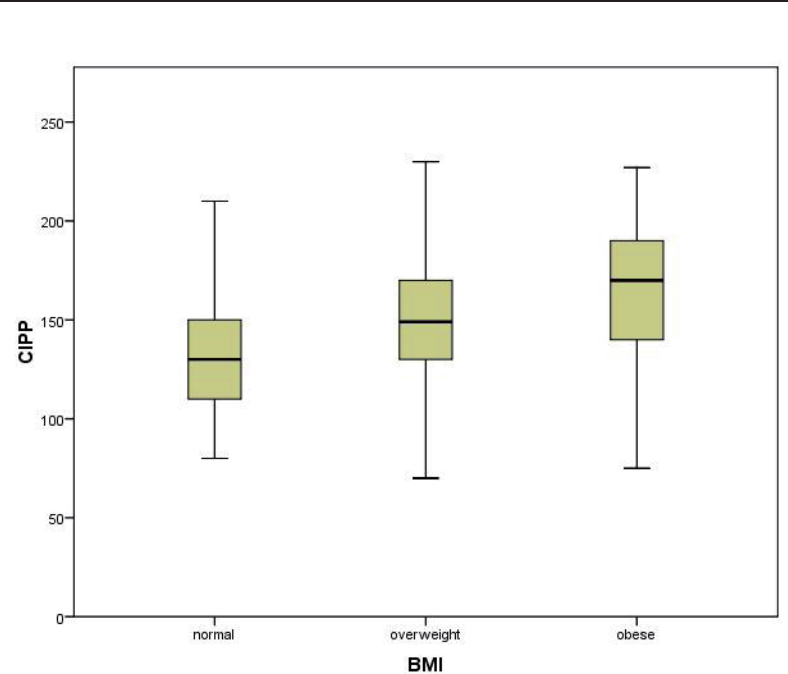
O) according to BMI 2